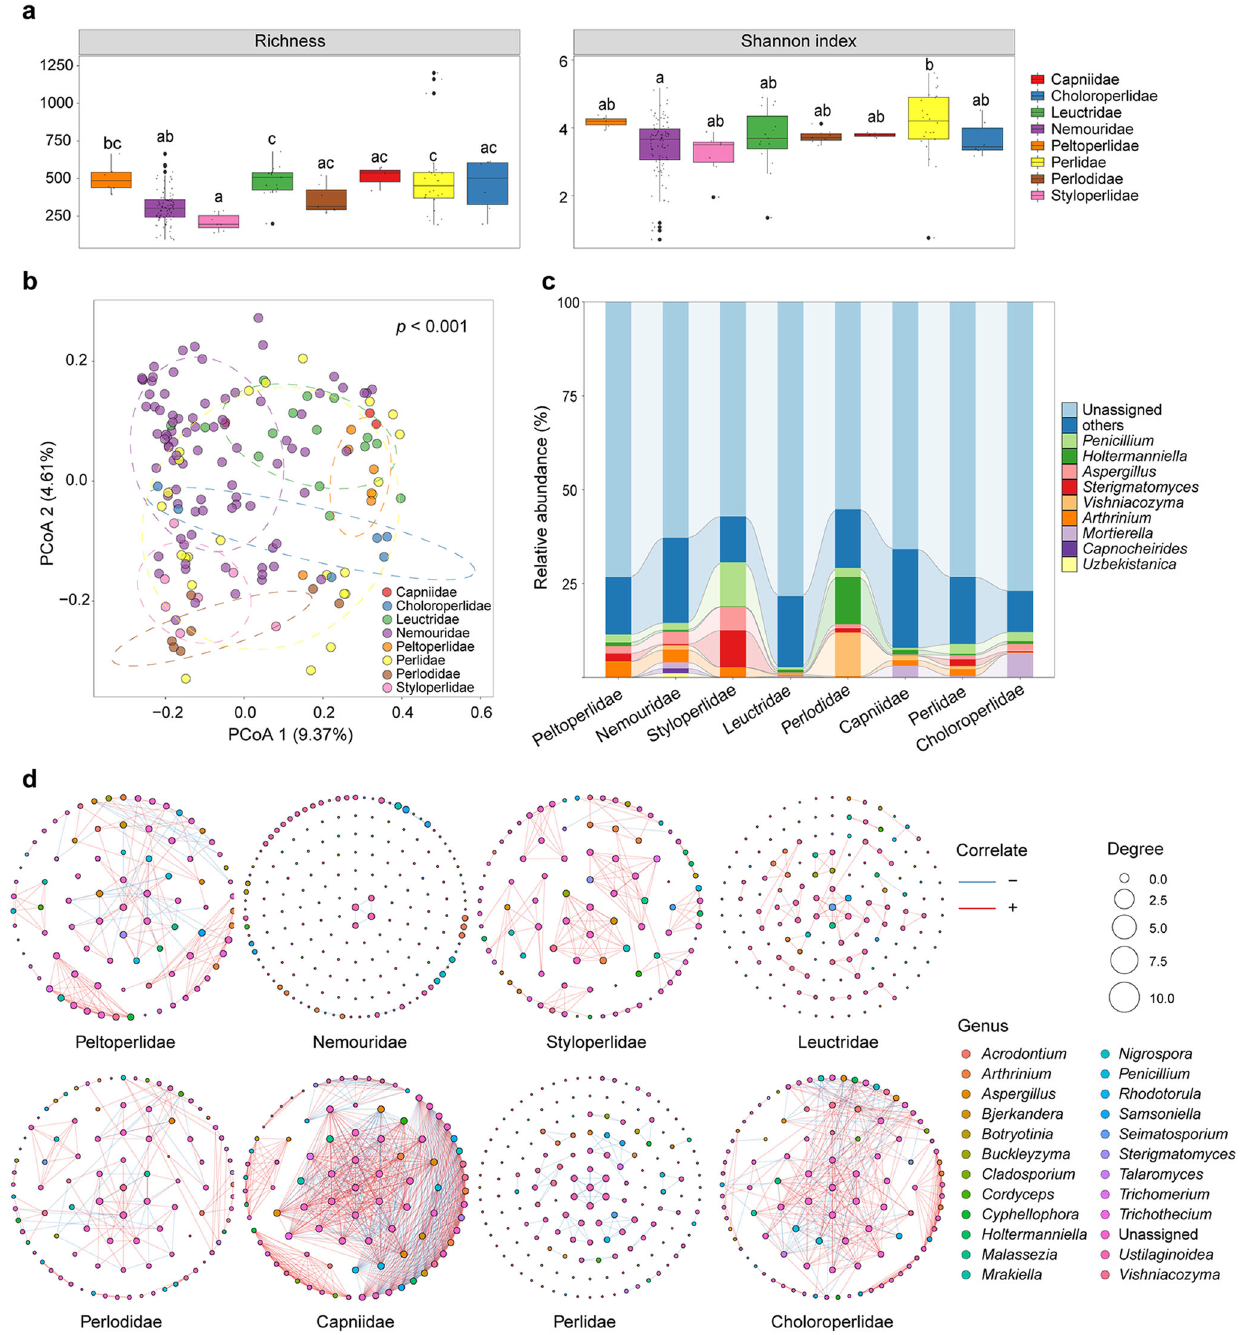
Fig. 2 Fungal community diversity and composition among eight stone fl y families. a Richness and Shannon indices of different stone fl y fungal communities. Different letters denote signi fi cant differences between stone fl y families with ANOVA tests ( p < 0.05). b Principal coordinate analysis (PCoA) of fungal community Bray-Curtis dissimilarities with permutational analysis of variance among different stone fl y families. The variation explained by each principal coordinate is denoted in parentheses. c Relative abundances of each fungal genus in different stone fl y families. d Co-occurrence networks of the fungal communities from each stone fl y family based on Spearman ’ s correlation analysis between OTUs. Blue and red lines represent signi fi cant negative and positive correlations, respectively. The sizes of the points indicate the relative abundance of OTUs in each microbial